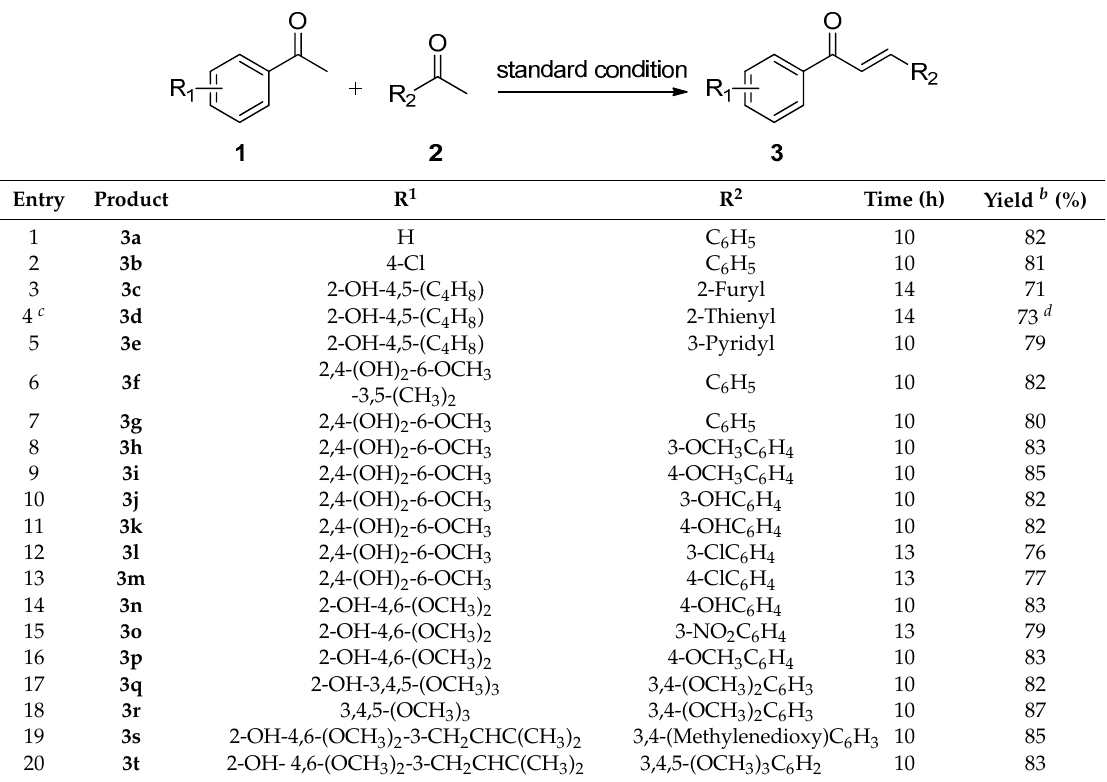
Table 3. The synthesis of chalcones catalyzed by VB 1 a .